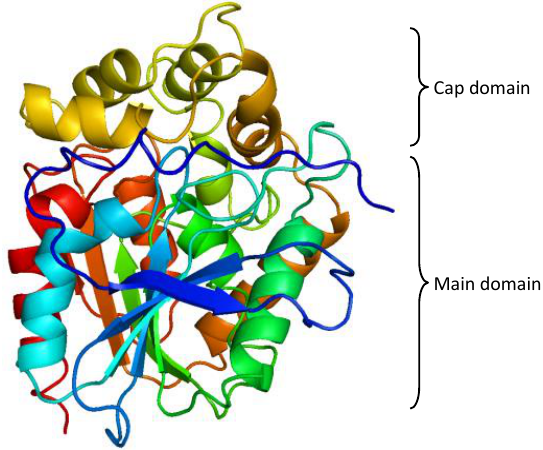
Fig. 1. Representative structure of haloalkane dehalogenase . PDB ID: 2HAD